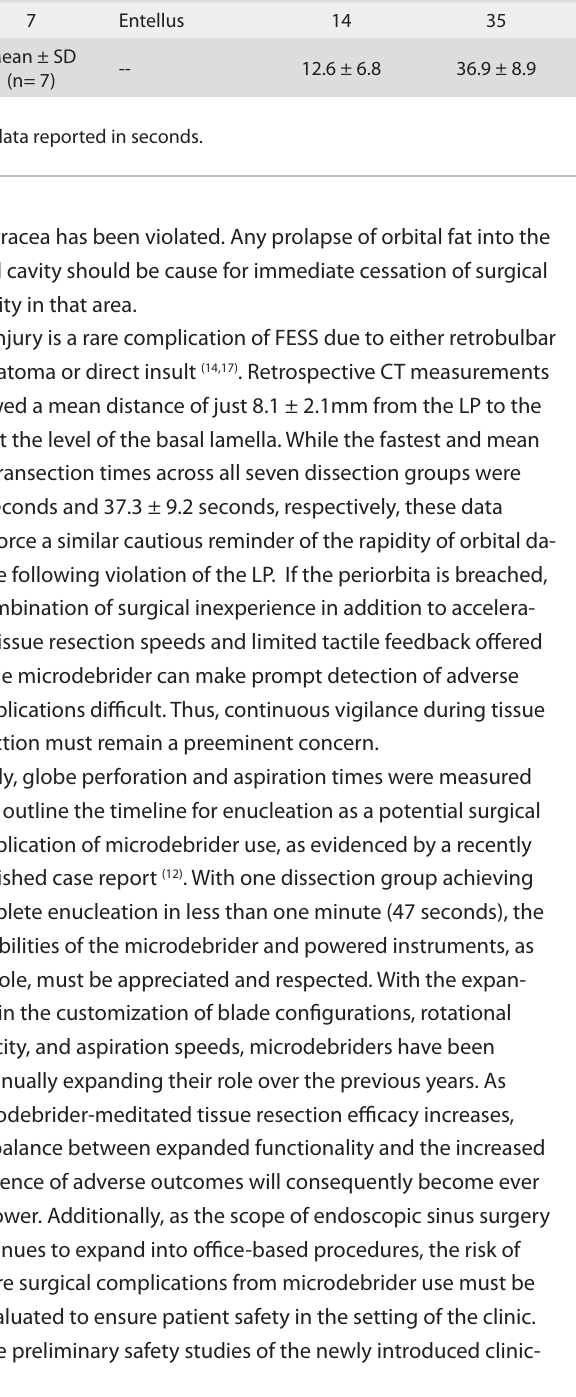
a. All data reported in